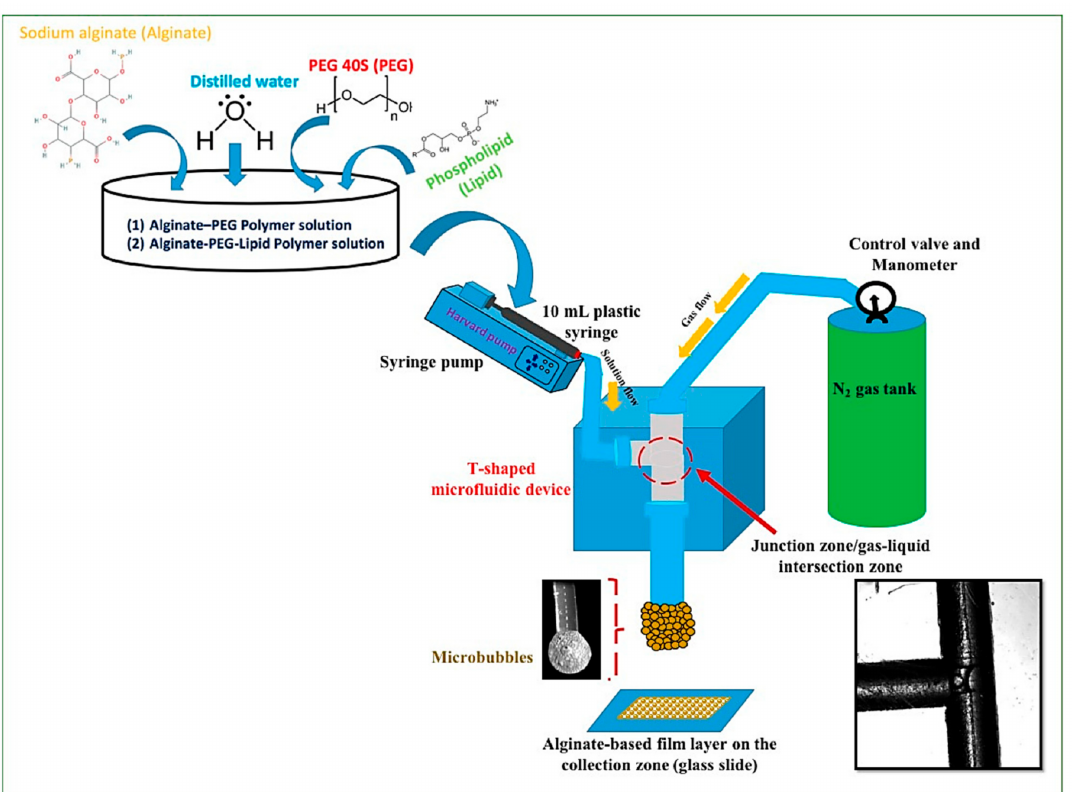
Figure 2. Schematic representation showing the T-shaped microfluidic junction processing of an alginate-based porous film formation from bubble bursting. Reprinted from an open-access source [45].